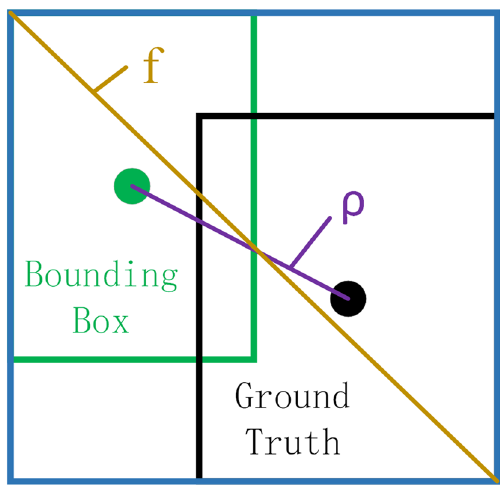
Figure 1. Theory of CIoU loss regression of bounding